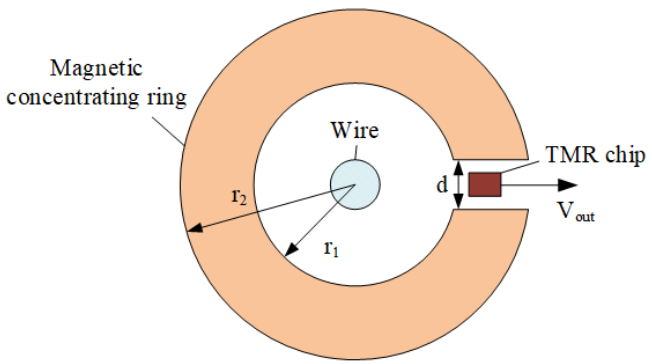
Figure 1. TMR current sensor structure.